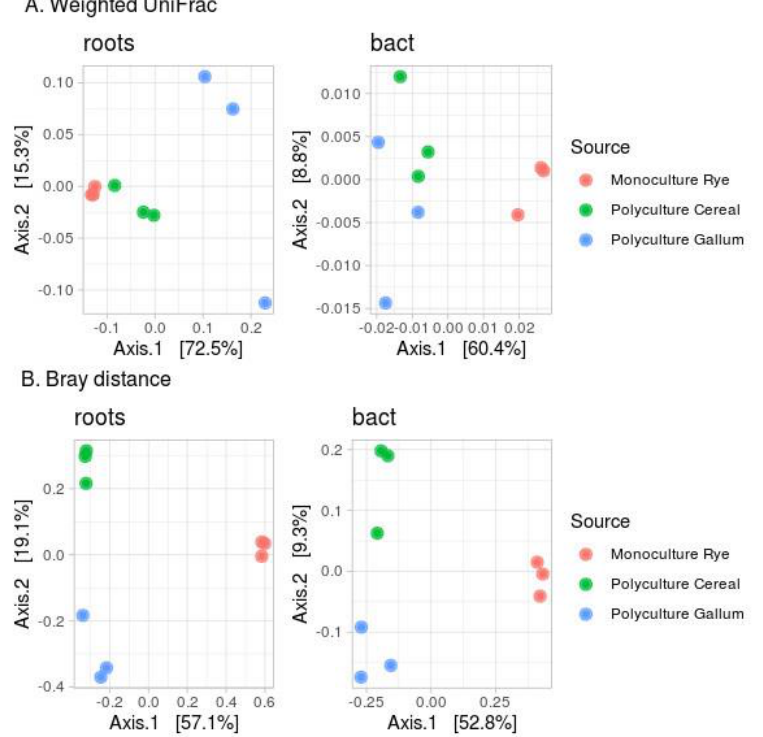
Figure 4. Beta − diversity indices for plant and bacterial communities. ( A ): Weighted UniFrac; ( B ): Bray distance.